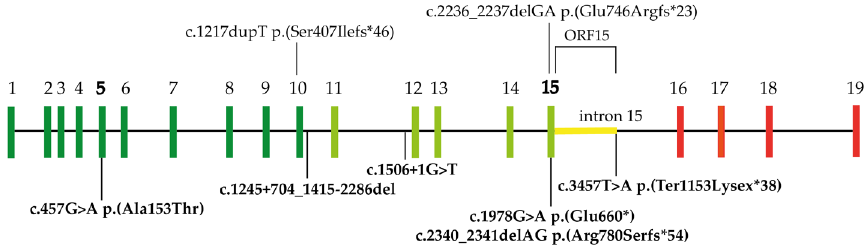
Figure 1. Schematic representation of the RPGR gene with locations of the variants (novel variants are written below the scheme and bolded). Vertical lines represent exons, while the horizontal black line represents introns. Part of intron 15 (marked with yellow) was additionally transcribed in the RPGR ORF15 isoform, whi le exons 16 –19 (marked with red) were absent.